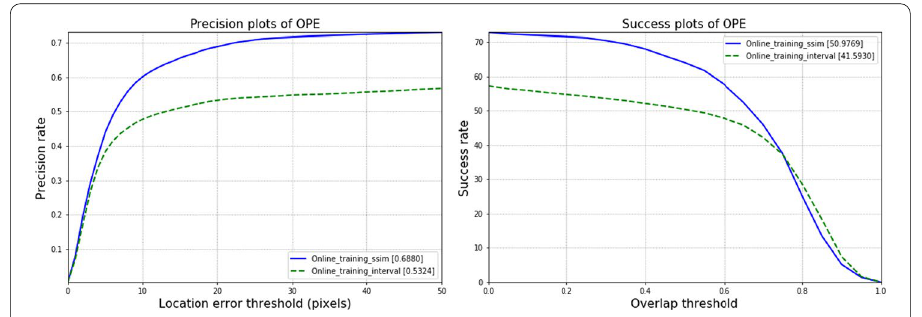
Fig.15 Success and precision plots on OTB2013 datasets with different online training methods